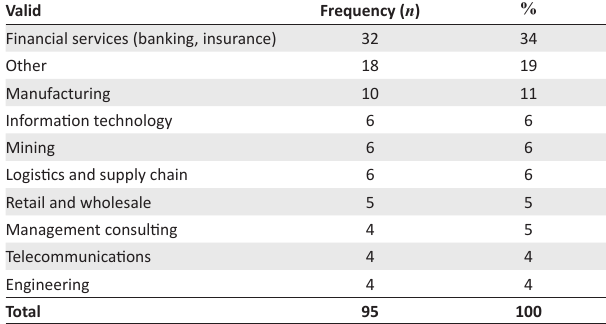
TABLE 3: Total number of survey respondents by industry ( n =